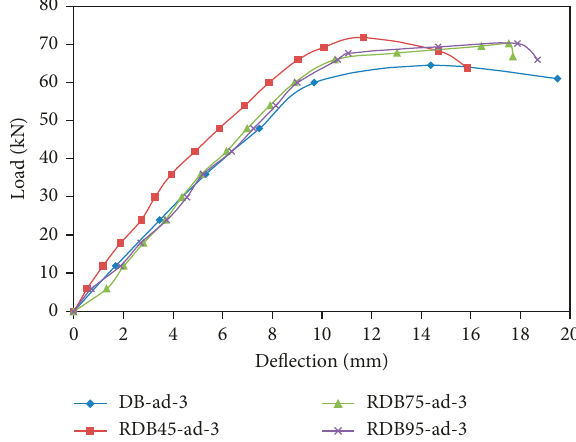
Figure 5: Load-deflection plot of shear-designed beams tested at a / d ratio 3.